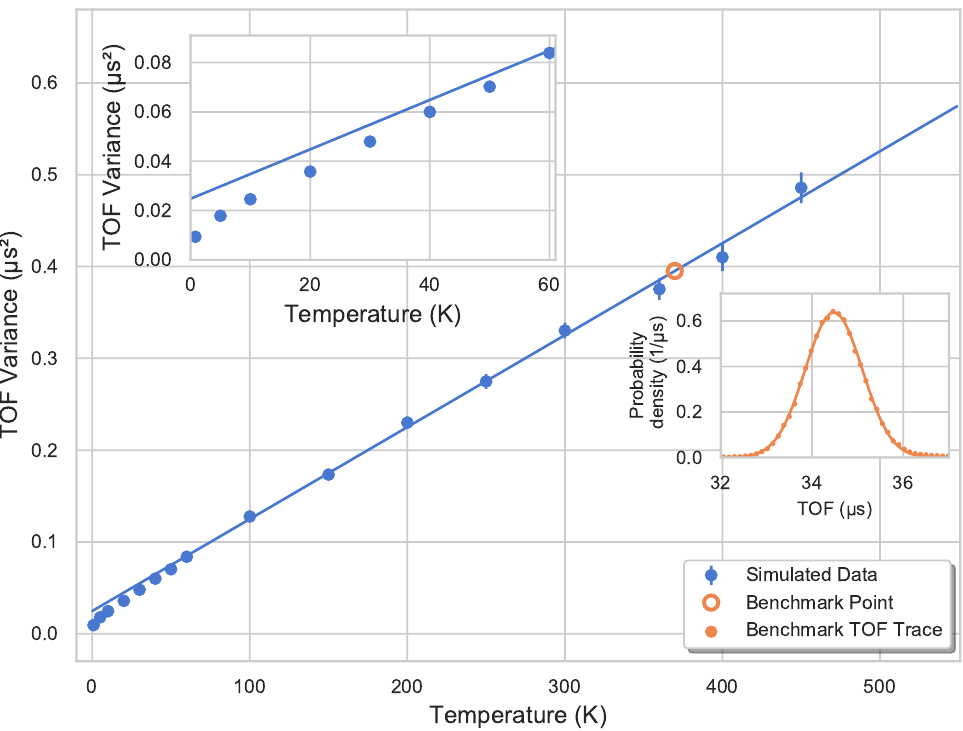
Figure 9. The variance of the TOF distribution, i.e., σ 2 , plotted as a function of the initial temperature of the ions in the trap before extraction onto the detector. The change in the linear slope can be seen in the left inset. It is interpreted as a consequence of the pockets arising at a temperature regime of about 60 K. Furthermore, the temperature from the corresponding TOF trace of the tomography measurements is derived to be 370 K, which is consistent with the Monte-Carlo simulations’ prediction. This TOF trace is shown in the right inset along with the Gaussian fit representing the